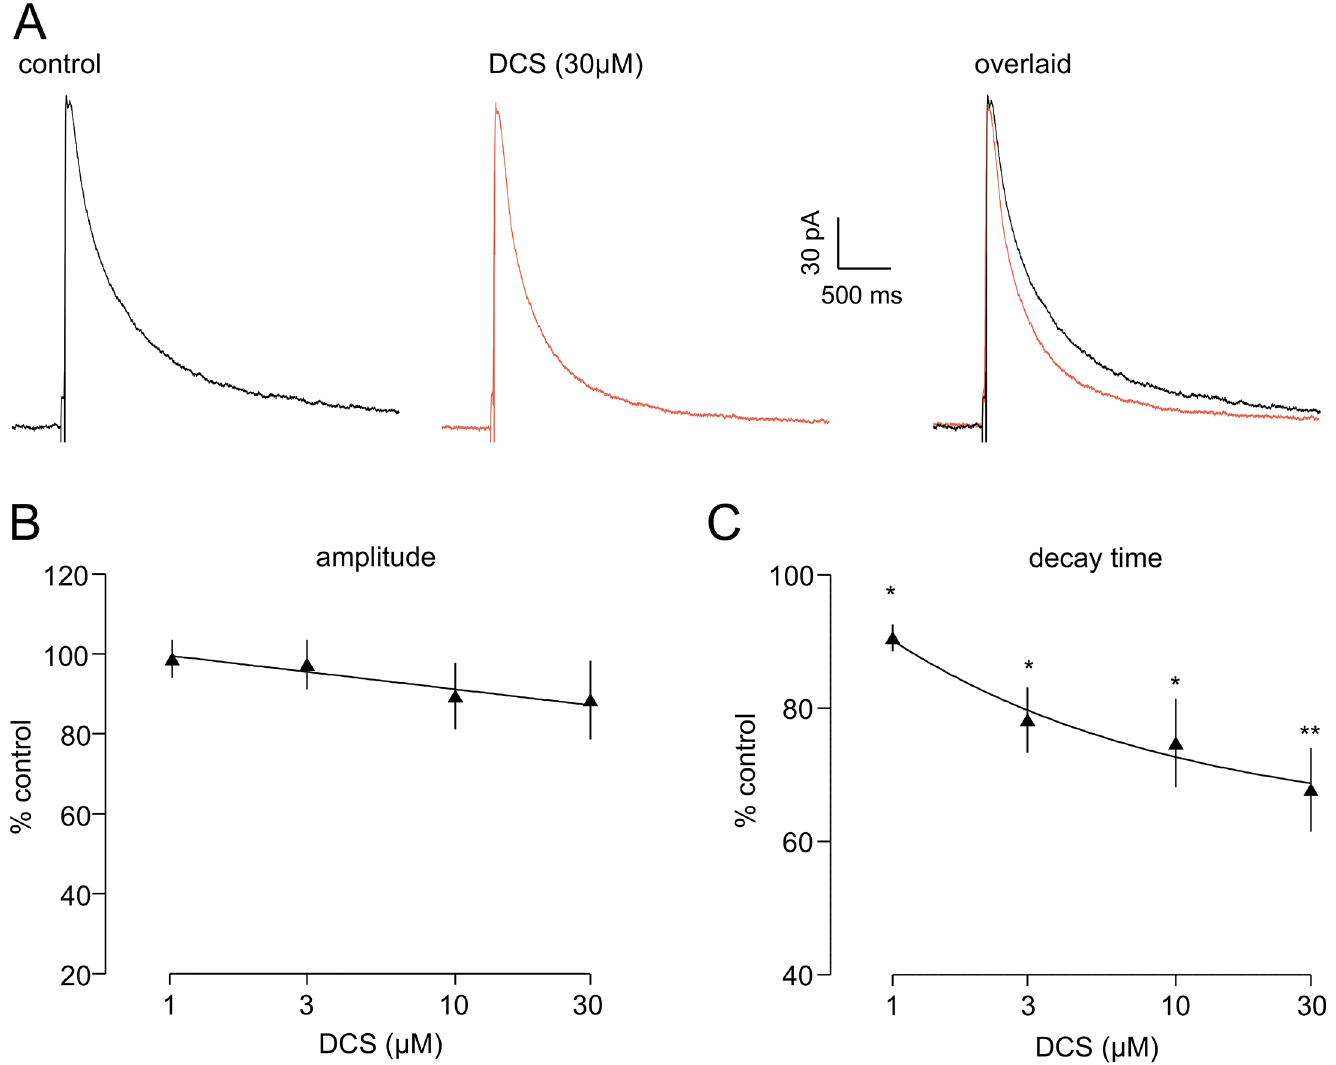
Fig 4. DCS decreases the decay time of eNEPSCs. A. Averaged traces for one neurone are shown for control and in the presence of 30 μ M DCS. The overlaid traces clearly show that the amplitude of the eNEPSC is unaffected whereas the response decay is substantially accelerated. The graphs show pooled data of cumulative concentration response curves for normalised data in six neurones for peak amplitude (B) and decay time (C) . DCS failed to significantly alter peak amplitude at any concentration, but produced a concentration-dependent decrease in eNEPSC decay time. * P < 0.05; ** P < 0.01.